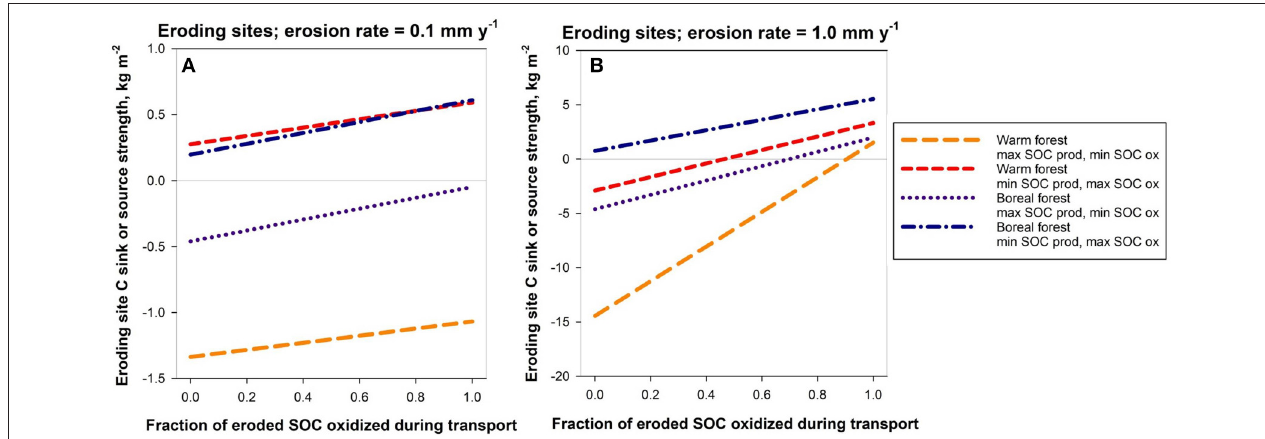
FIGURE 3 | The net C sink or source strength of eroding profiles as a function of the fraction of SOC oxidized during transport for a warm temperate forest and a boreal forest after 100 y of erosion at two specified erosion rates 0.1 mmy − 1 (A) and 1.0 mmy − 1 (B) . The two labeled scenarios represent contrasting assumptions about (1) potential enhancement of each depth’s SOC oxidation rate as it nears the surface upon erosion, and (2) potential decline of SOC production rates for each depth as it nears the surface upon erosion. Negative values indicate net C sinks; positive values indicate net C sources to the atmosphere. Note change in Y axis scaling across erosion rates. Max, maximum; min, minimum. See text for model description and definitions of maximum and minimum SOC production and oxidation.